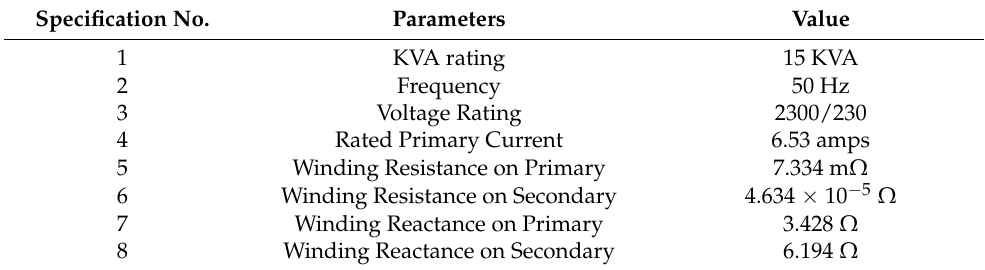
Table 2. Specifications of the single-phase transformer. Specification